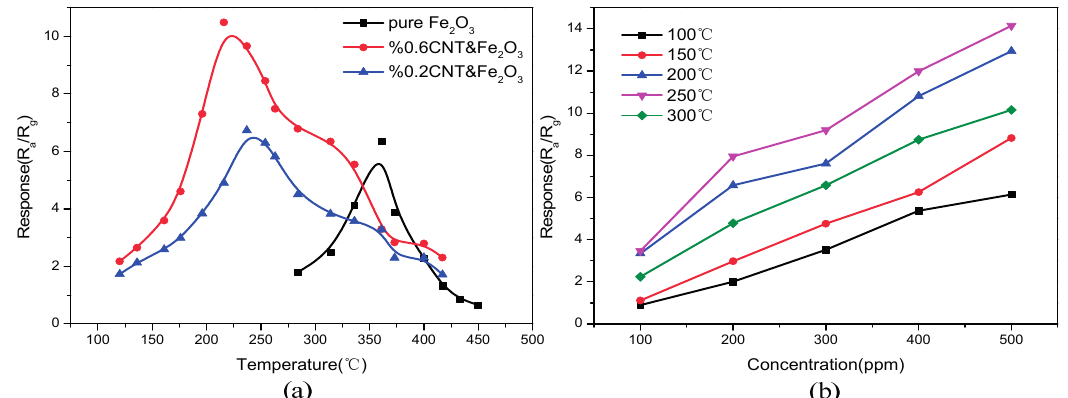
Figure 6. ( a ) Response of different samples in an acetone gas concentration of 400 ppm at various operating temperatures; ( b ) Response of a gas sensor at different sintering temperatures and gas concentrations.